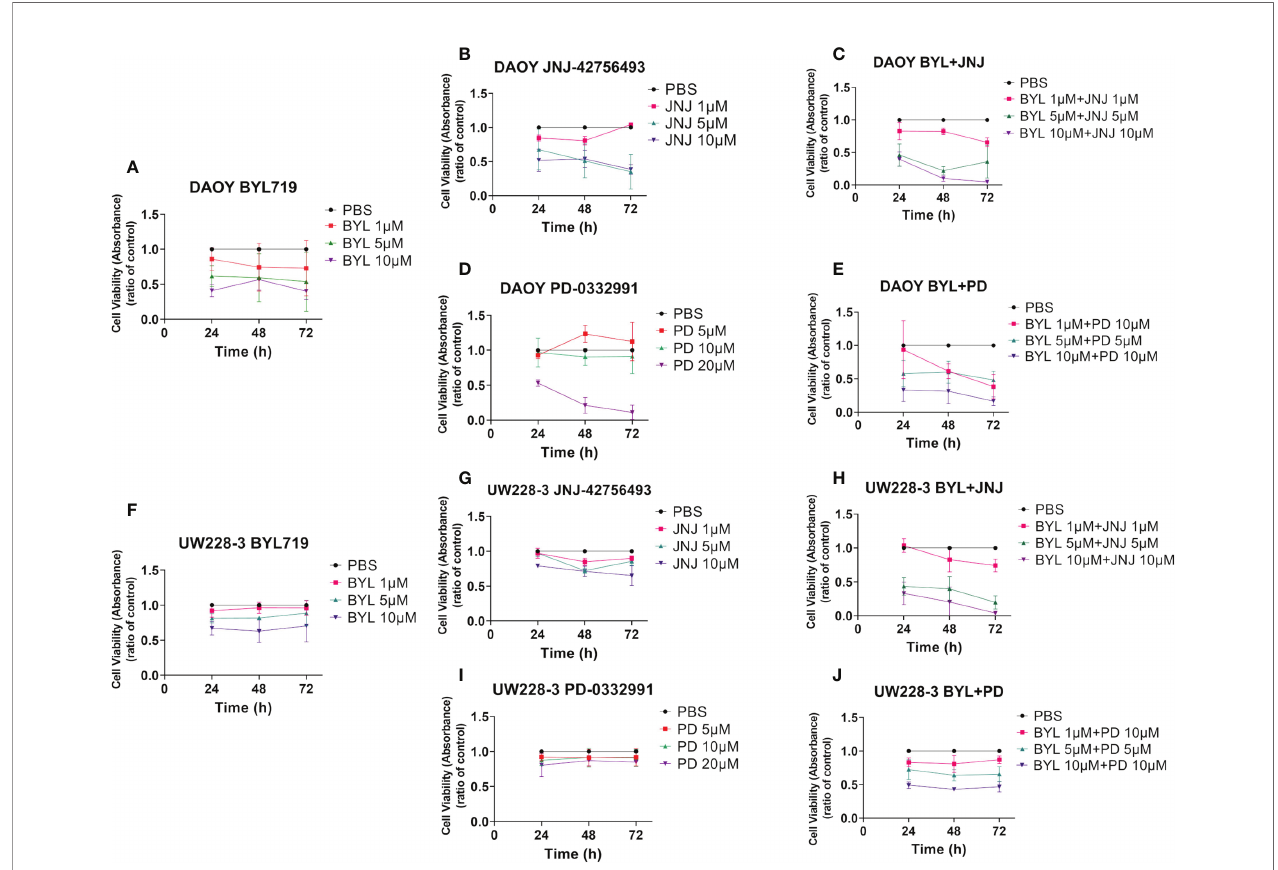
FIGURE 1 | WST-1 viability assays after single and combined treatment of PI3K, FGFR, and CDK4/6 inhibitors (BYL719, JNJ-42756493, PD-033299, respectively) on two MB cell lines (DAOY and UW228-3). Viability analysis of DAOY and UW228-3 respectively measured as absorbance, after single treatments for 24, 48, and 72 h with BYL719 (A, F) , FGFR JNJ-42756493 (B, G) , and PD-0332991 (D, I) , respectively. Combination treatments are shown in (C, E) for DAOY and (H, J) for UW228-3. The graphs represent mean values ± standard deviation (SD) from three experimental runs per cell line. BYL, BYL719; JNJ, JNJ-42756493; PD, PD-0332991.